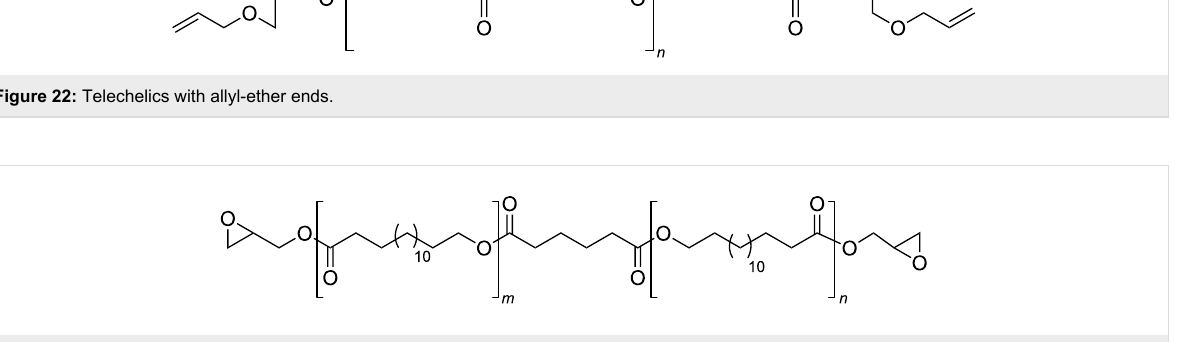
Figure 23: Telechelics with ends functionalized as